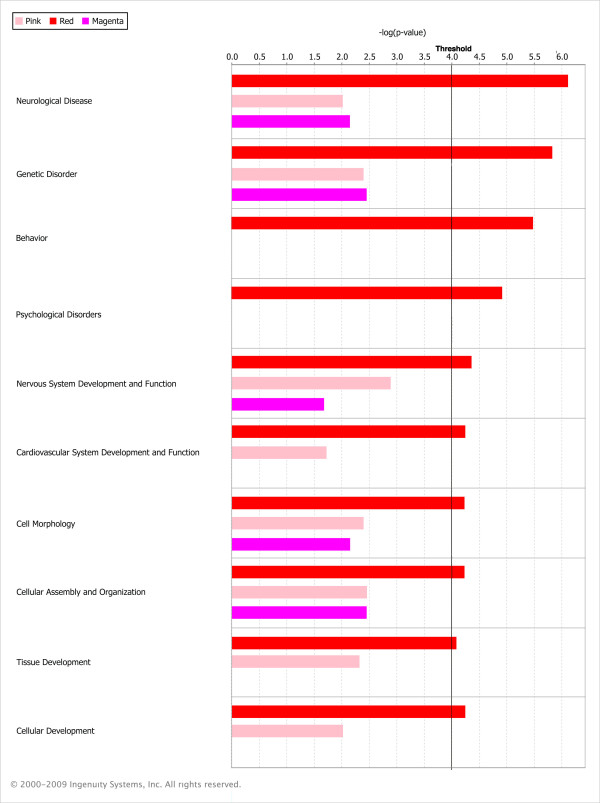
Color-coded bar plot depicting Ingenuity Pathway Analysis results. We used Ingenuity Pathways Analysis (Ingenuity® Systems, http://www.ingenuity.com) to study the ontology of genes in the Red, Pink and Magenta modules. Results for categories enriched by at least one module at the p < 10e-04 level are depicted in the color-coded bar plot.